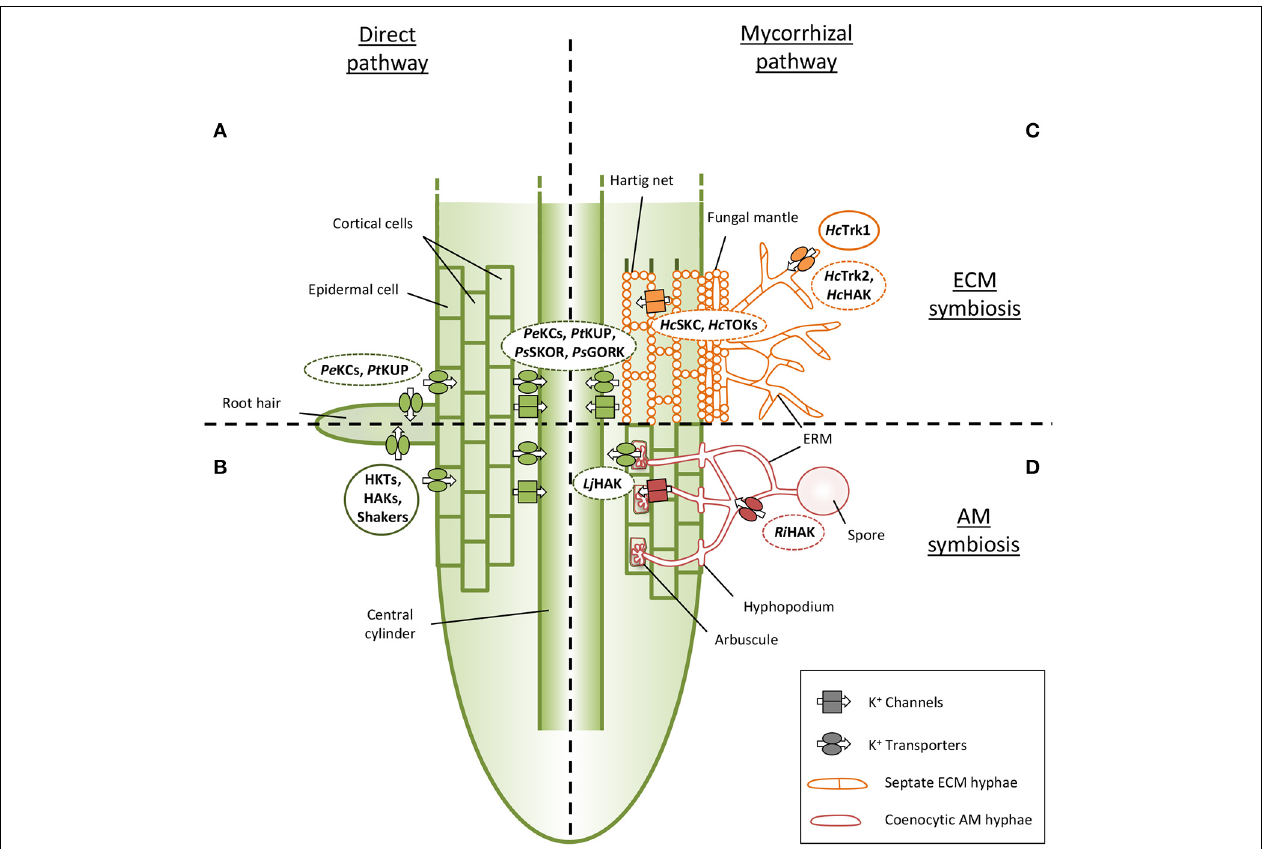
apoplasm. (D) EST library of Rhizophagus irregularis allows the identification of several K + transport related proteins (Casieri et al., 2013), and transcriptomic analysis revealed an high overexpression of a K + transporter in inoculated Lotus japonicus (Guether et al., 2009). Full lines indicate transport systems whose capability in K + transport was verified. Dotted lines indicate transport systems whose involvement in K + transport during mycorrhizal symbioses is suggested. ECM fungal structures: Extraradical hyphae (ERM), fungal mantle and Hartig net. AM fungal structures: ERM, spore, hyphopodium and arbuscule. Plant root cells: roots hair, epidermal cells and cortical cells, central cylinder. Hc , Hebeloma cylindrosporum ; Ri , Rhizophagus irregularis ; Pe , Populus euphratica ; Pt , Populus tremula ; Ps , Pinus sylvestris ; Lj , Lotus japonicus